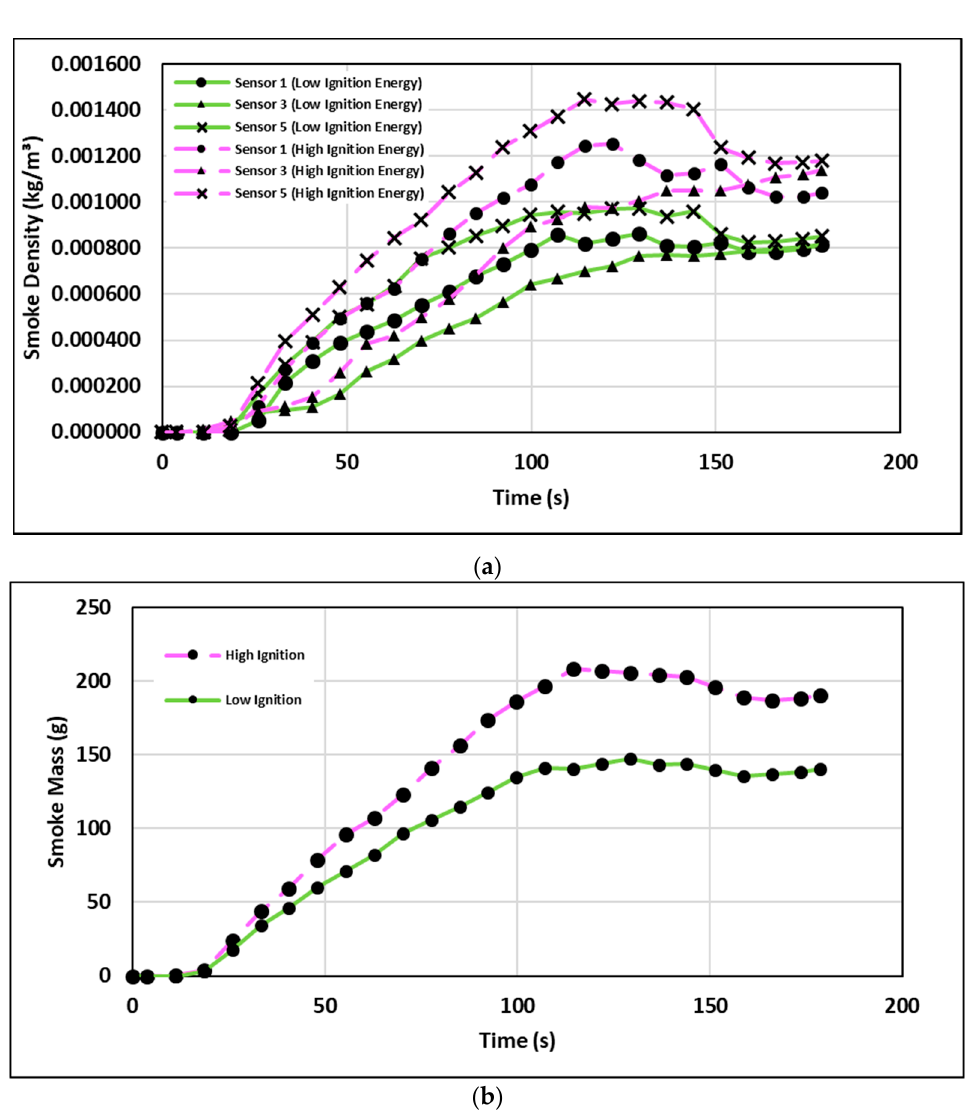
Figure 9. ( a ) Smoke density comparison due to varying ignition energy. ( b ) Smoke mass variations due to different ignition energy.